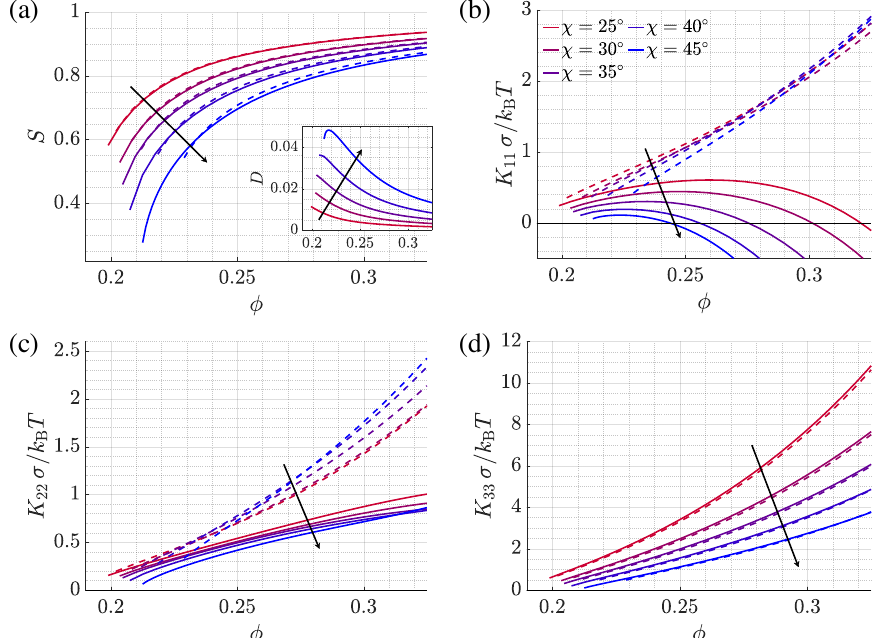
Figure 3. ( a ) Order parameters S and D (inset), and ( b ) splay, ( c ) twist and ( d ) bend elastic constant, as a function of the volume fraction φ . Values obtained using the non-local form of the ODF, Equation (5) (solid lines), and the local uniaxial form, Equation (6) (dashed lines), for the nematic phase of acute angle V-shaped particles with different values of the bend